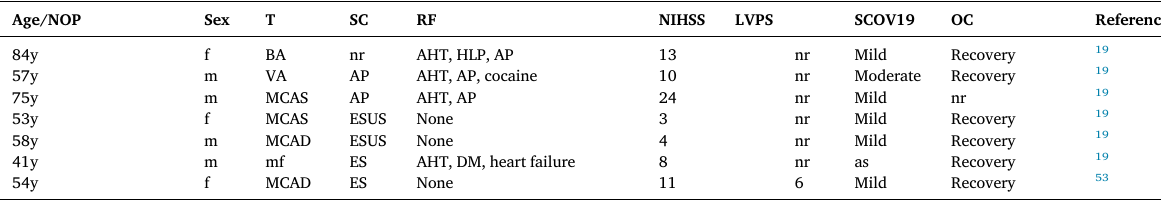
ACAS/D, Left/right Anterior Cerebral Artery; ACLA, Anti-Cardiolipin-Antibodies; AF, Atrial Fibrillation/Atrial Flutter; AHT, Arterial Hypertension, as, Asymptomatic; AP, Angiopathy (macro- or micro-angiopathy); AV, Arti fi cial Ventilation; BA, Basilary Artery; CMP, Cardiomyopathy; CP, Coagulopathy; DD, D-dimer; DM, Diabetes; DS, Dissection; ES, Embolic Stroke; ESUS, Embolic Stroke of Unknown Signi fi cance; FG, Fibrinogen; GGO, Ground Glass Opacities without requiring AV; HLP, Hyperlipidemia; ICAS/D, Left/right Internal Carotid Artery; LVO, Large Vessel Occlusion; LVPS; Latency Between Positive Virus-PCR and onset of stroke (days); MCAS/D, Left/right Median Cerebral Artery; mf, Multifocal; MIA, Microangiopathy; mRS, modi fi ed Ran- kin Scale; NOP, Number of Patients; nr, Not Reported; OC, Outcome; PCAS/D, Left/right Posterior Cerebral Artery; PFO, Patent Foramen Ovale; PICAS/ D, Left/right Posterior Inferior Cerebelli Artery; PTT, Prothrombin Time; RF, Risk Factors; RS, Ranking Scale; SC, Stroke Classi fi cation According to TOAST criteria; SCOV19, Severity of COVID-19 infection at time of stroke onset; SM, Smoking; T, Territory; uk, Unknown; VAS/D, Left/right Vertebral Artery; VL, Vasculitis; y, Years.